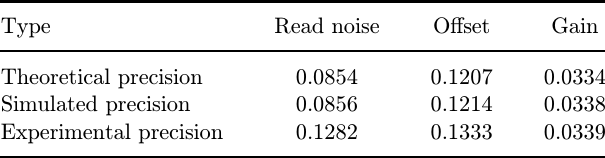
Table 2. Precision in the pixel-dependent noise